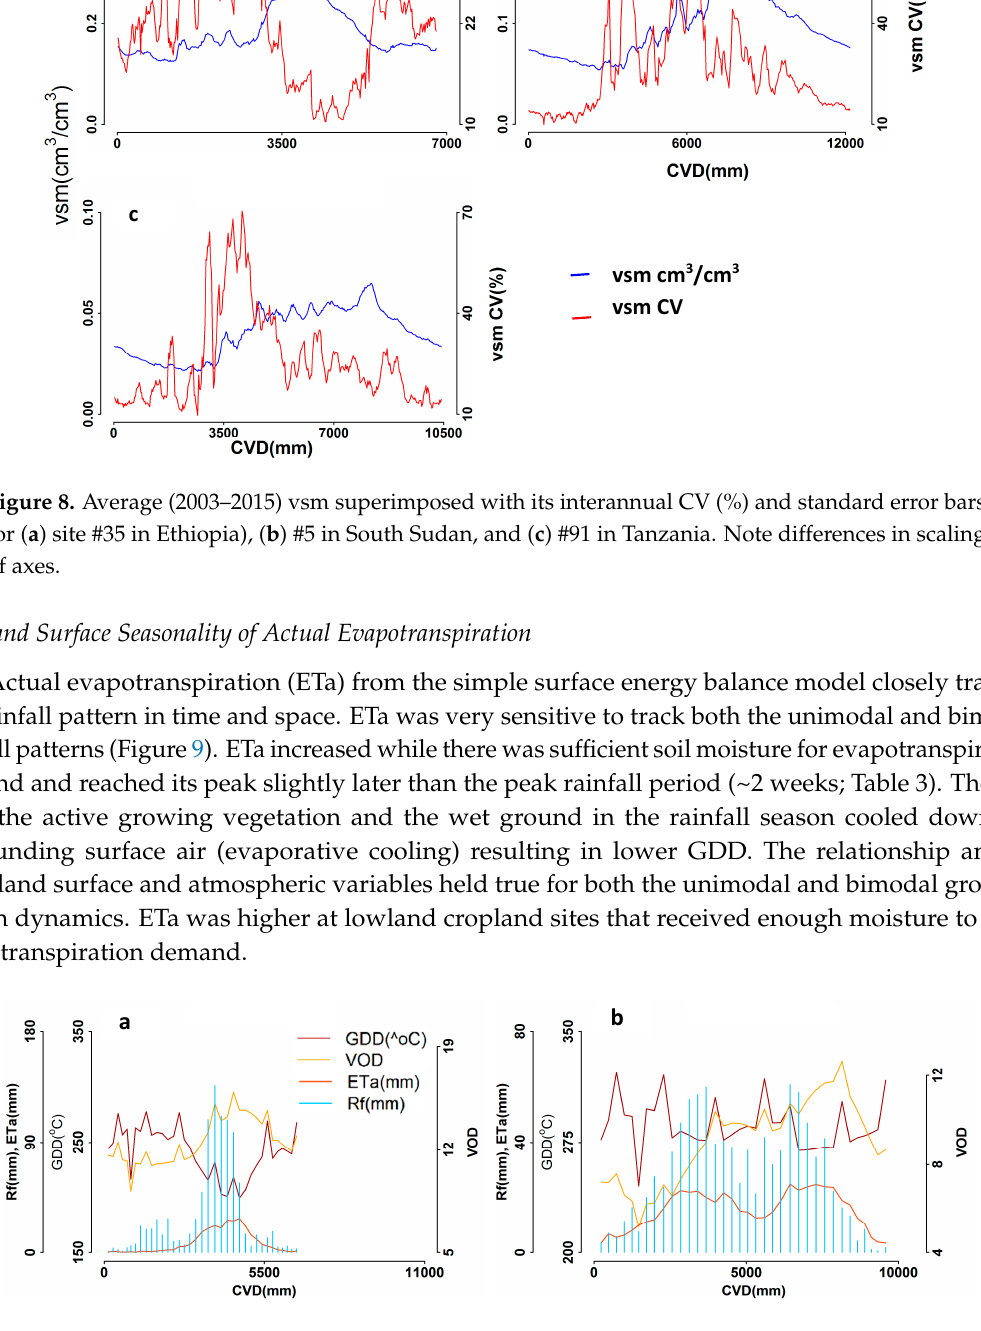
Figure 9. Time series of MODIS rainfall, SSEB ETa, and AMSR GDD and VOD for ( a ) #87 in Ethiopia and ( b ) #14 in Tanzania for 2003–2015.